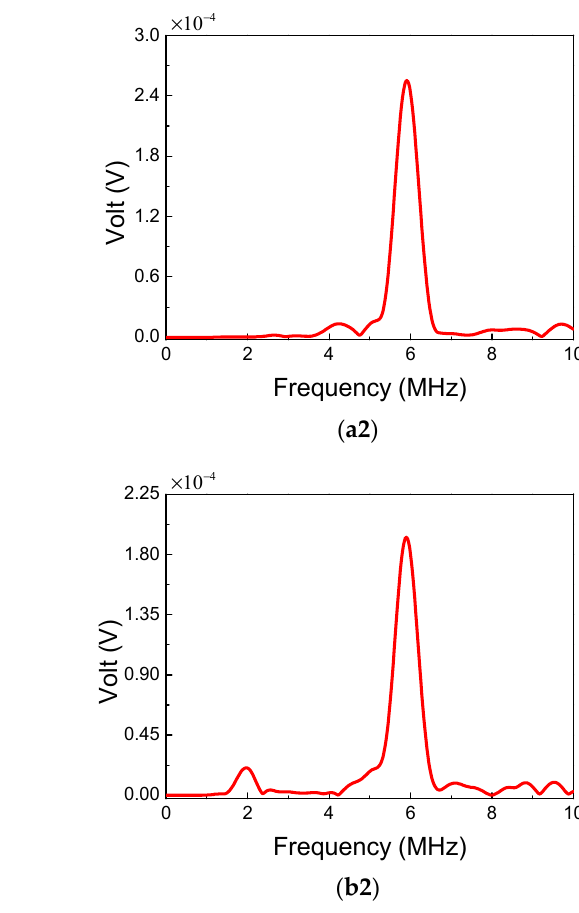
Figure 16. Time-domain and frequency-domain of experimental signals. ( a1 , a2 ) The resonant wave signal mixing at the position of 80 mm. ( b1 , b2 ) The resonant wave signal mixing at the position of 105 mm .